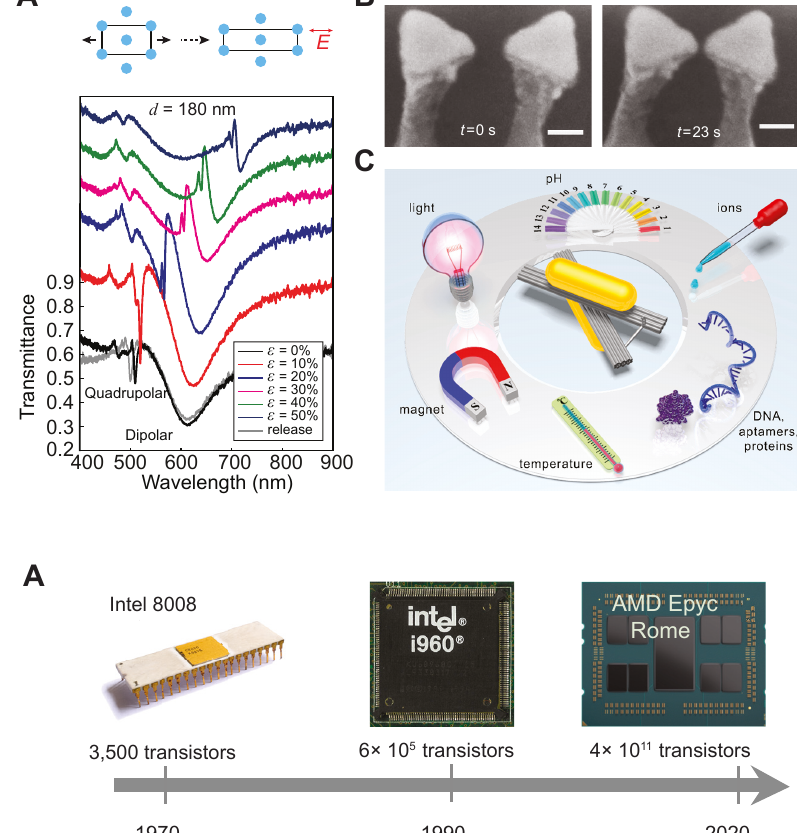
Figure 10: Tunable near-field plasmon coupling: (A) Optical response of PNAs fabricated on a stretchable soft substrate canbereversiblytunedbystrainmodulation. Adapted from the study by Yang et al. [163]; (B) Inter-antenna gap of a pillar-bowtie PNA can be tuned under electron beam illumina- tion to realize active devices. Scale bars, 50 nm. Adapted from the study by Roxworthy et al. [178]; (C) An illustration of possible ways for dynamic recon fi guration of DNA-based PNAs. Adapted from the study by Zhou et al. [179]. PNA, plasmonic nano- antenna.